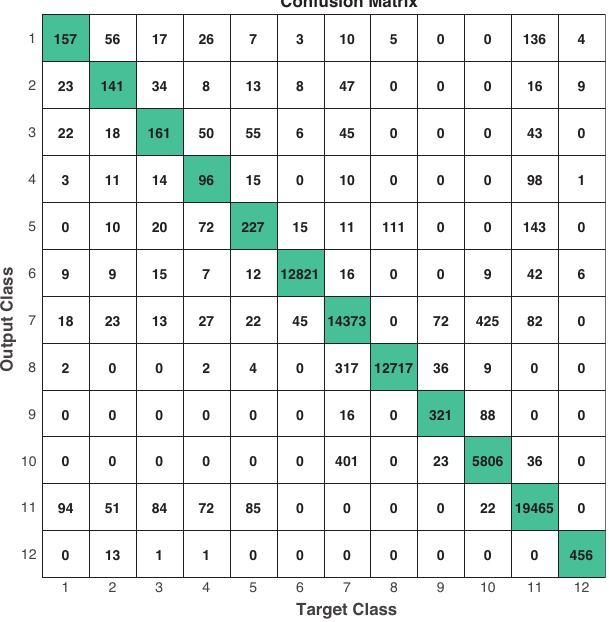
Figure 18. Confusion matrix in testing using video recordings. Numbers in diagonal represent the times a target class is estimated correctly. Performance: accuracy = 95.1%, precision = 71.8%, sensitivity = 71.3%, specificity = 99.5% and F 1 - score =